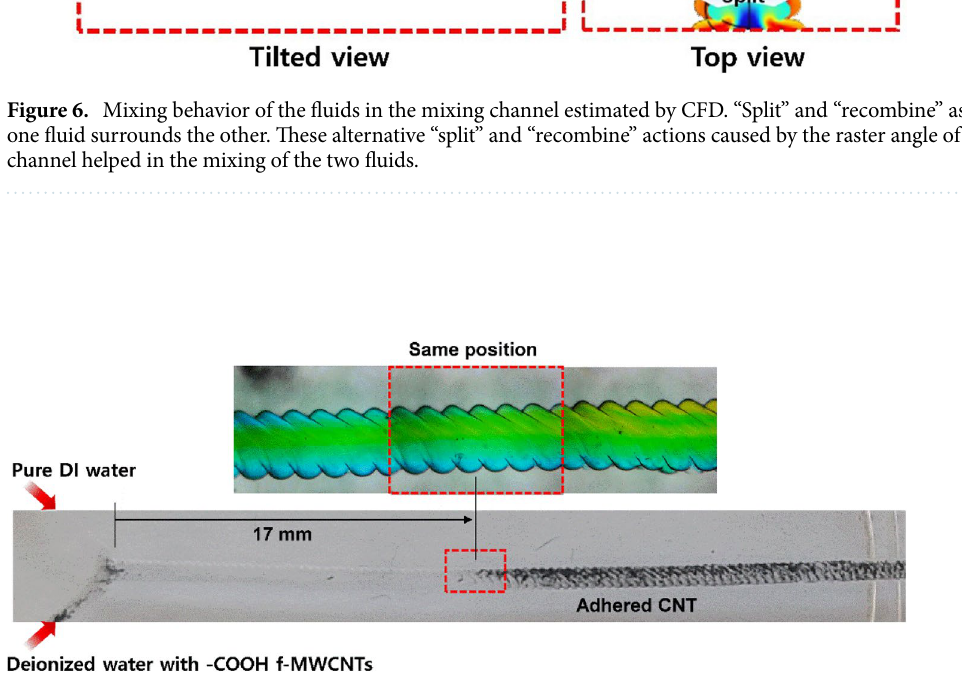
Figure 7. Result of the experiment using CNTs-dispersed water to verify the “split” and “recombine” behavior of fluids in the mixing channel. The flow rate for both inlets was 120